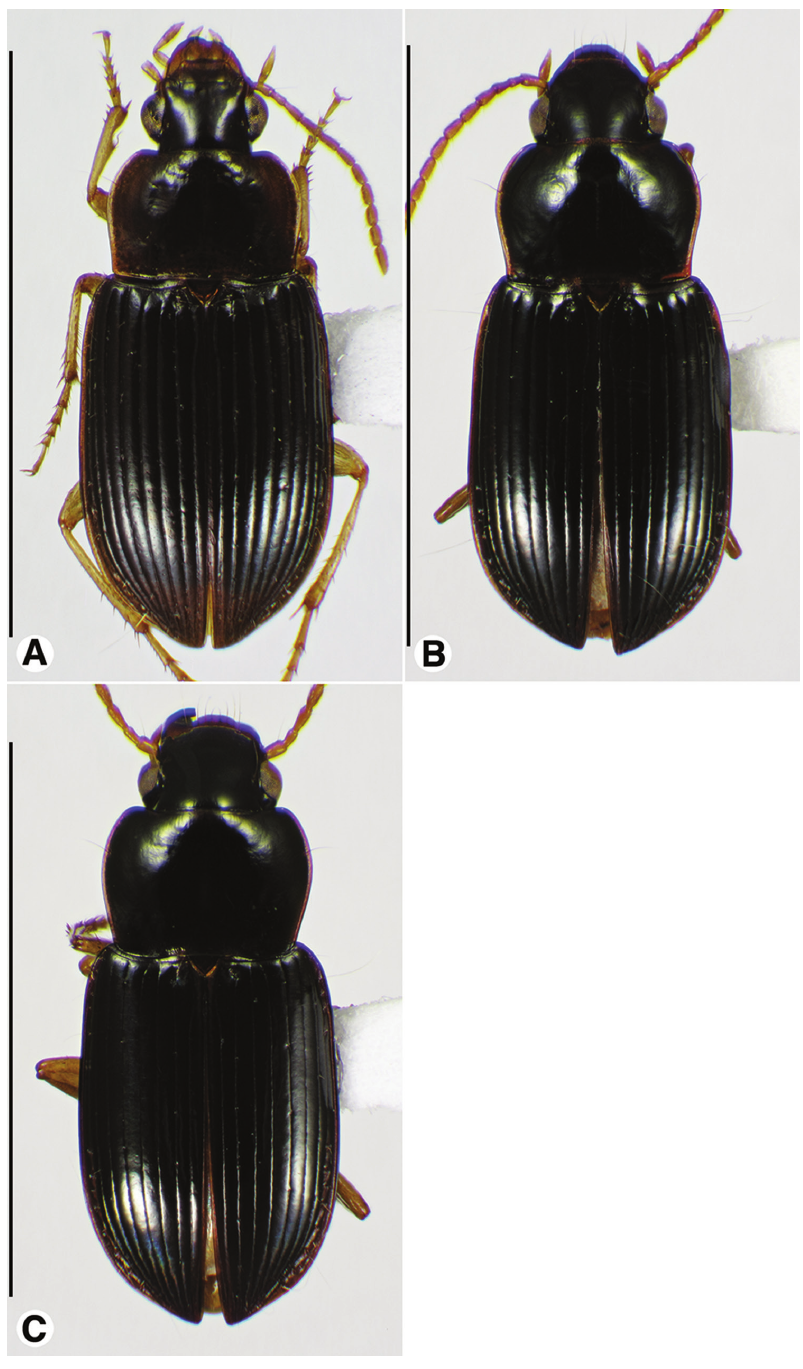
Figure 35. Habitus digital images of Selenophorus nonseriatus species group, dorsal aspect. A S.irec sp. n. B S. iviei sp. n. C S. nonseriatus Darlington. Scale bars 5